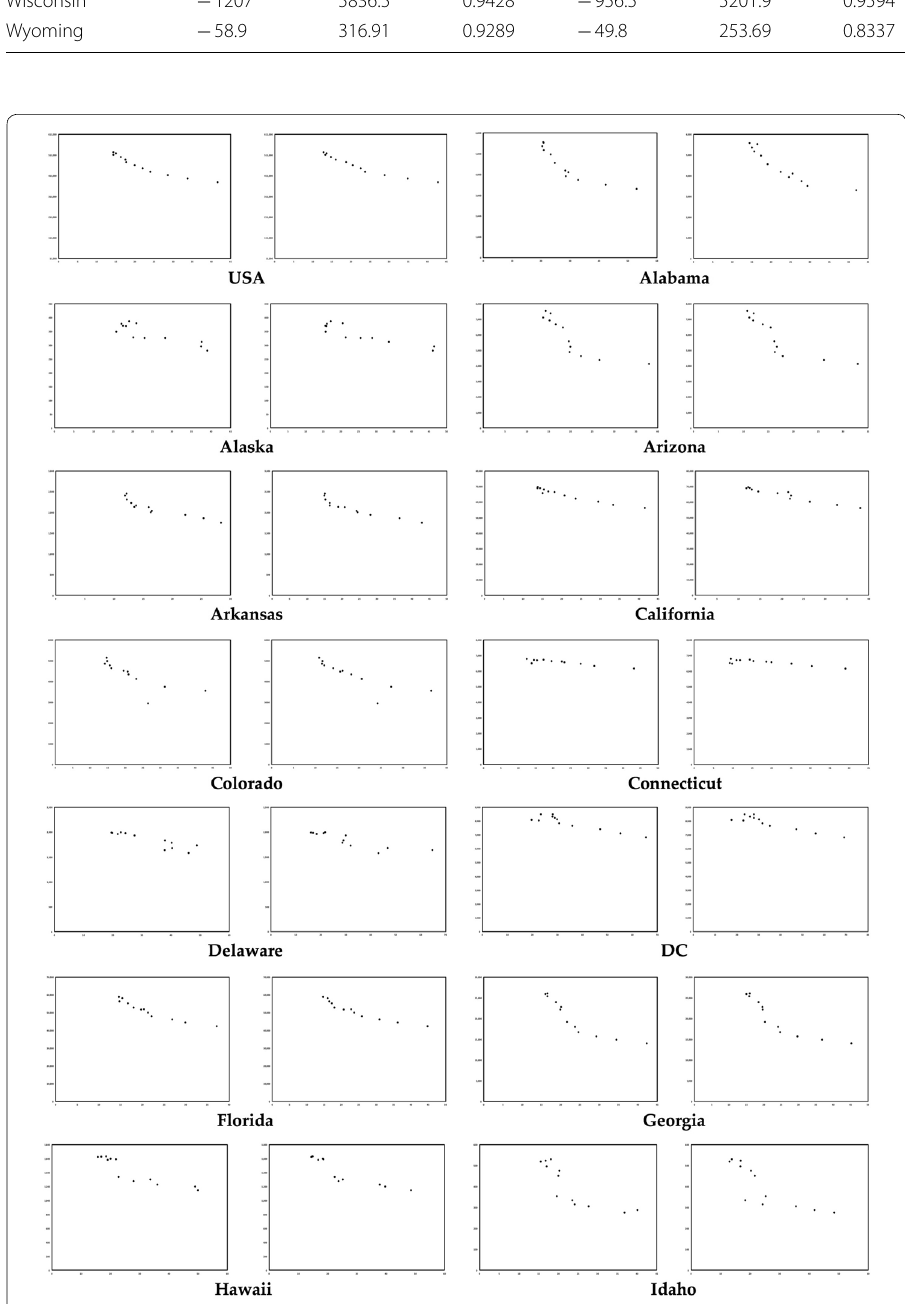
Fig. 4 ‘AIDS Prevalence’ vs. Google Trends ‘AIDS (Search Term)’ and ‘AIDS (Illness)’ from January 2004 to December 2015 (USA;